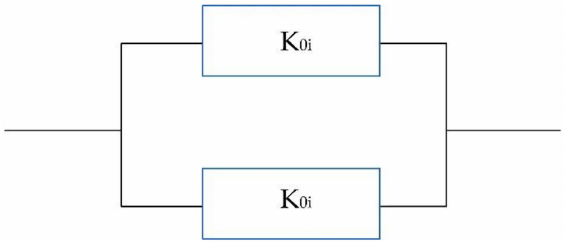
Figure 7. The reliability diagram for the first reduction station (A or